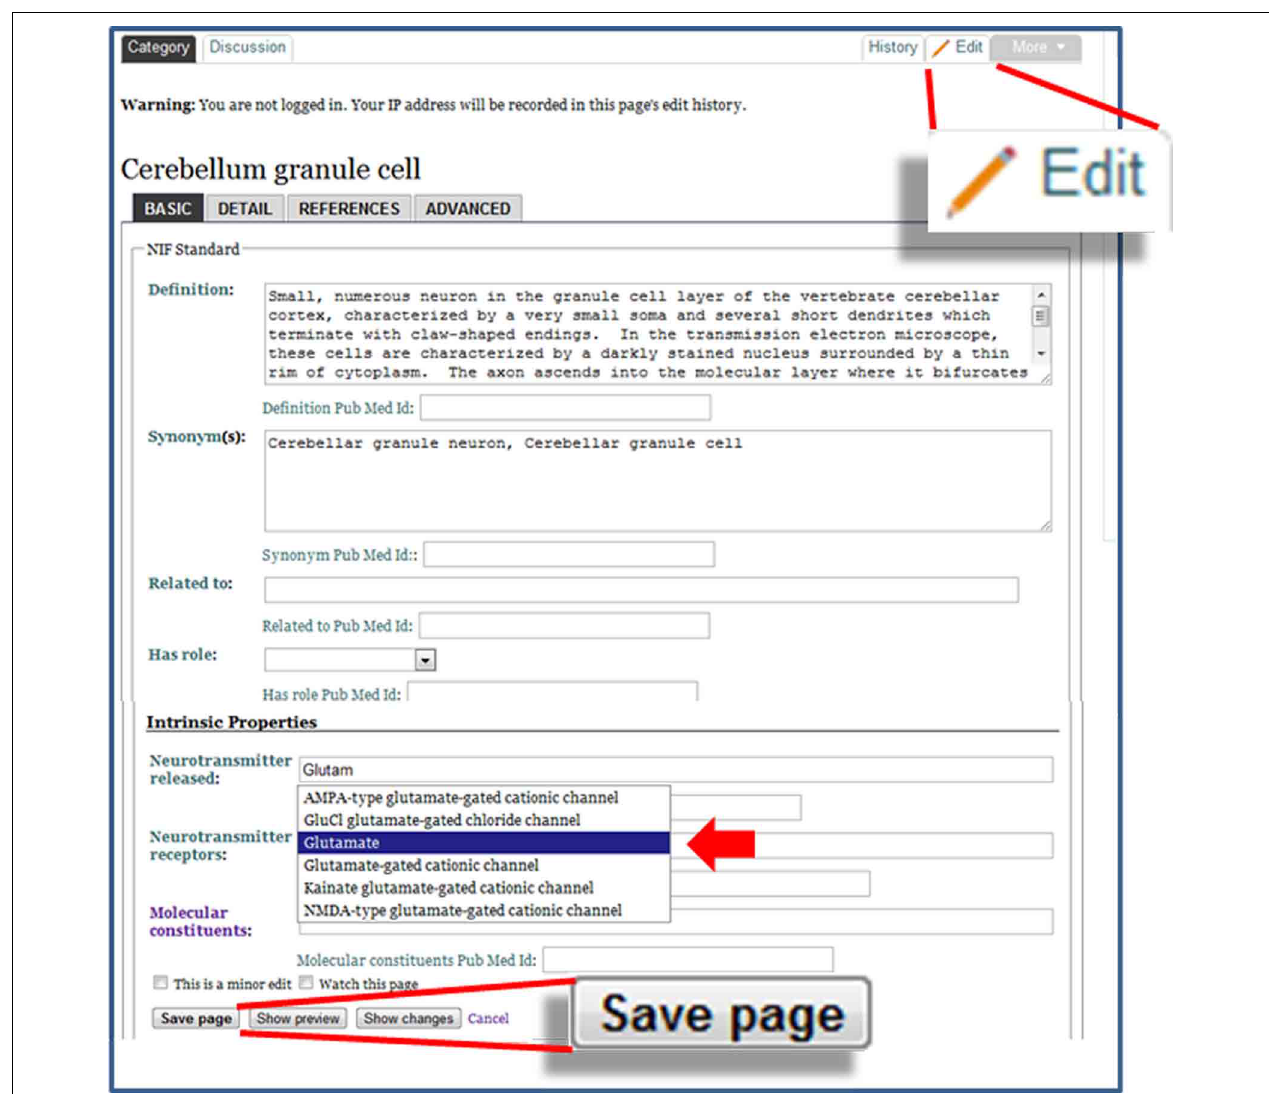
FIGURE 3 | The edit form for the Cerebellum granule cell page. The form is invoked by clicking the Edit button, shown in the enlargement in the upper right. Text boxes enable the user to make edits to the fields of information on the page. Fields whose values link to other category pages have an